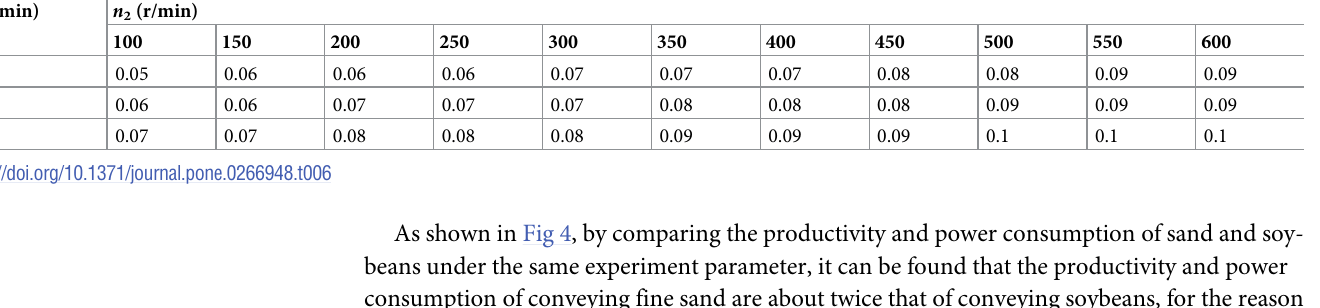
PLOS ONE | https://doi.org/10.1371/journal.pone.0266948 June 16,